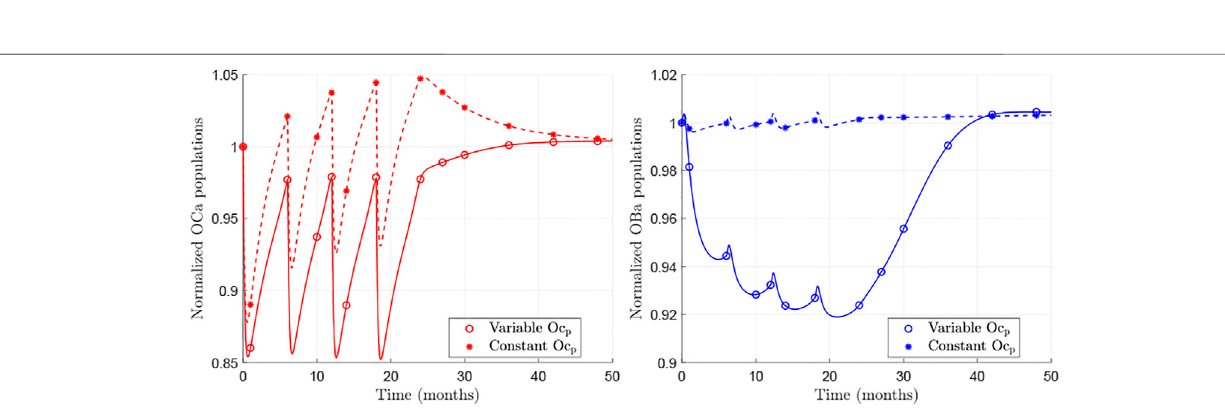
FIGURE 3 | Normalised evolution of active osteoclasts (left) and active osteoblasts (right) obtained with BCPM ext (solid) and BCPM st (dashed). The lines represent the continuous evolutions predicted by the models and the asterisks mark the values at those time points analysed in the clinical study by Bone et al. (Bone et al., 2011).